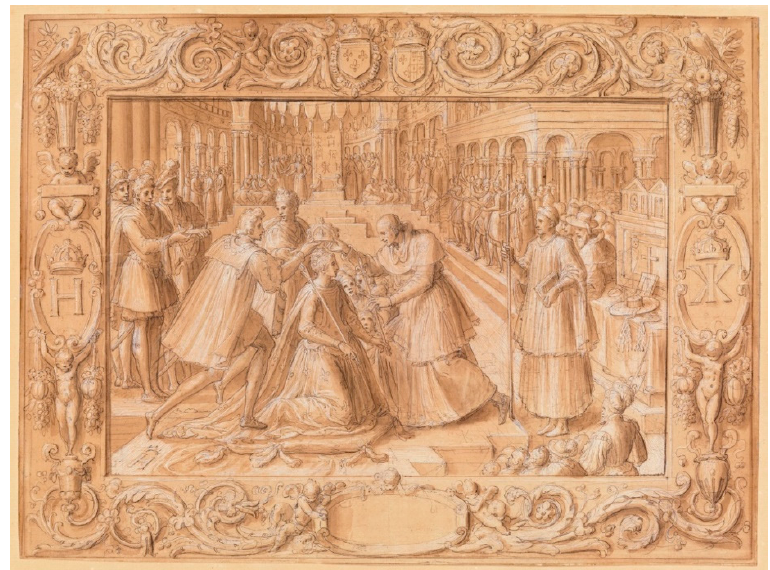
Figure 2. Antoine Caron, Coronation of Catherine de Medici in the Basilica of Saint-Denis, drawing in the series executed for “l’Histoire Françoyse de nostre Temps”, manuscript commissioned by Nicolas Houel, apothecary, and given to Catherine de Medici, RF29752. 15-recto, Paris, Musée du